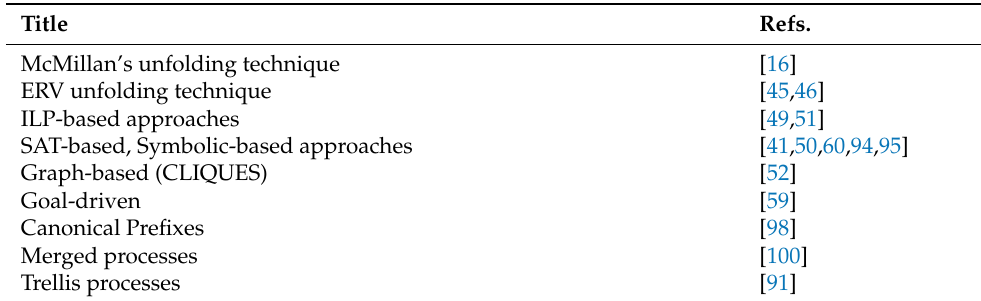
Table 2. A list of the major contributions found within the concurrency community for recent decades concerning the net unfolding